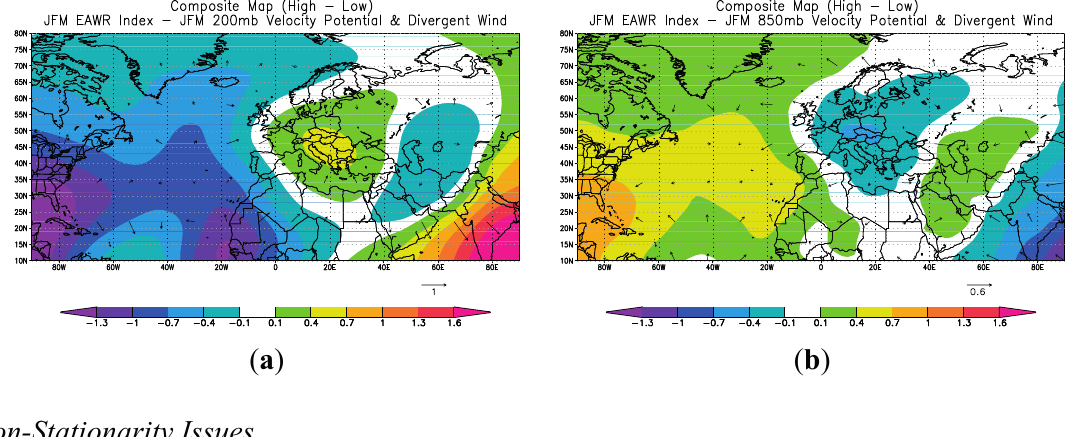
Figure 7. ( a ) 200 hPa velocity potential (shaded) and divergent wind (wind bars) composite map (difference between the averaged maps for which the normalized EAWR JFM index was higher (lower) than 1 ( − 1) standard deviation); ( b ) 850 hPa velocity potential (shaded) and divergent wind (wind bars) composite map (difference between the averaged maps for which the normalized EAWR JFM index was higher (lower) than 1 ( − 1) standard deviation). Units are: 10 6 m 2 /s for the velocity potential and m/s for the divergent